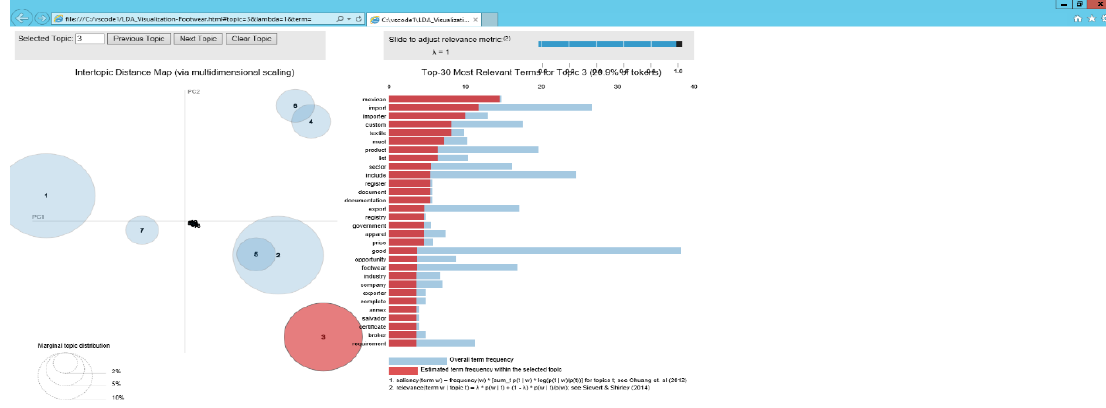
Figure 9. Footwear: Topic 3. This image shows Mexico as the third ranked country.